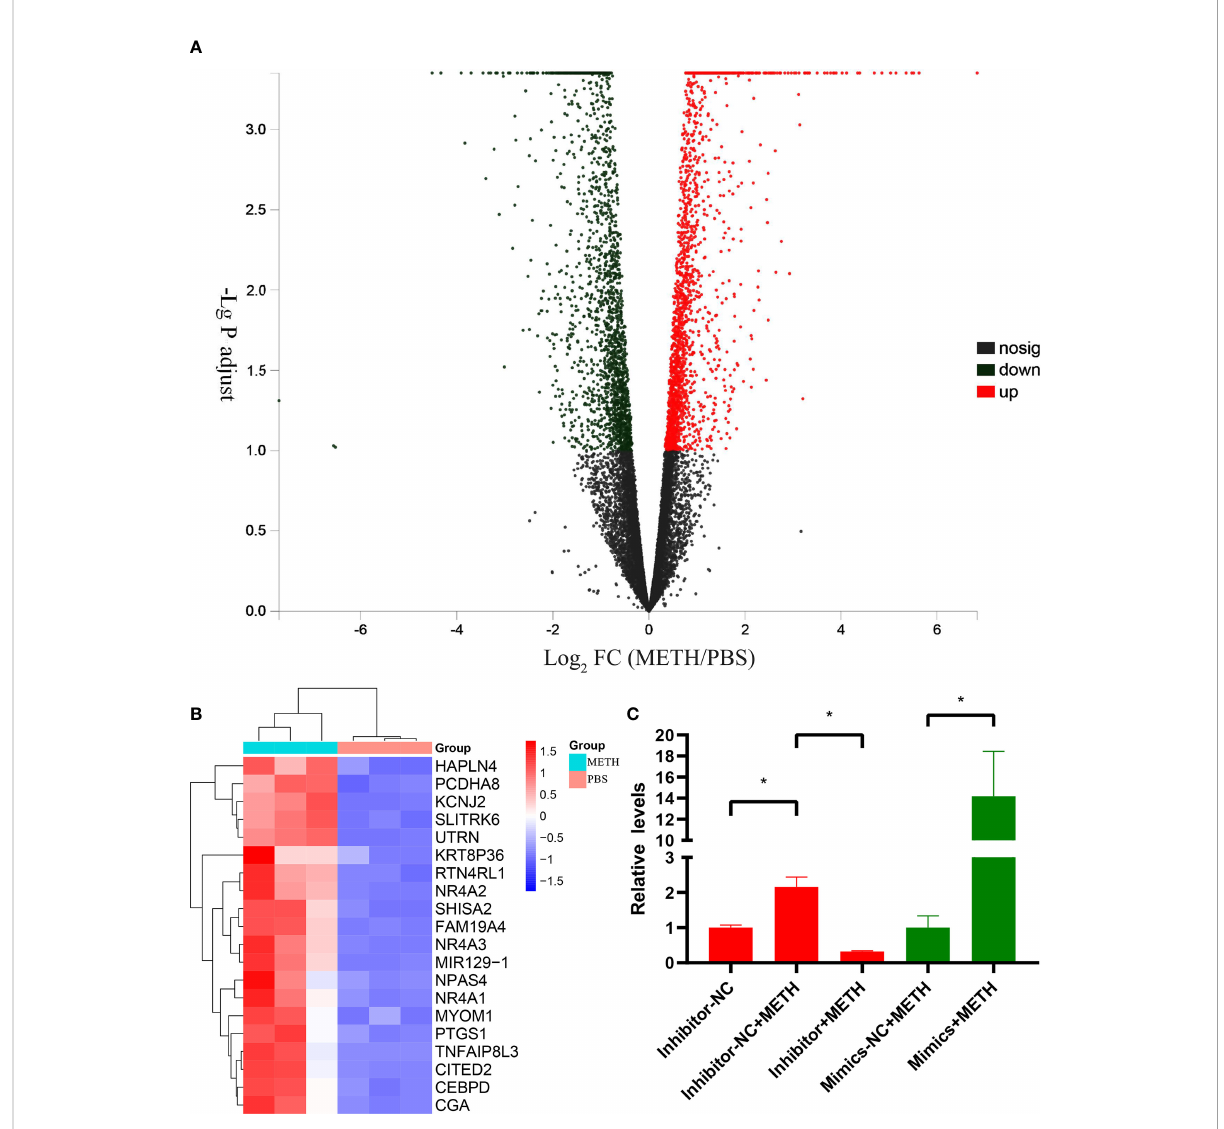
FIGURE 1 DEGs between METH-treatment group and PBS-treatment group in SH-SY5Y cell lines. (A) Volcano plots of DEGs. The horizontal coordinates are the values of the fold change in gene expression differences and the vertical coordinates are the values of the statistical tests for differences in gene expression changes, both logarithmically processed. Each point in the graph represents a speci fi c gene, red points indicate signi fi cantly up-regulated genes, blue points indicate signi fi cantly down-regulated genes, and black points are insigni fi cantly differentially expressed genes. (B) Heatmap of top 20 up-regulated DEGs. Three samples were tested in each of the METH and PBS groups, and the relative expression of genes is indicated by red or blue squares. (C) Relative expression levels of miR-129-1-3p tested by RT-qPCR. Signi fi cant differences are indicated by asterisks. Error bars represent the mean ± SEM.